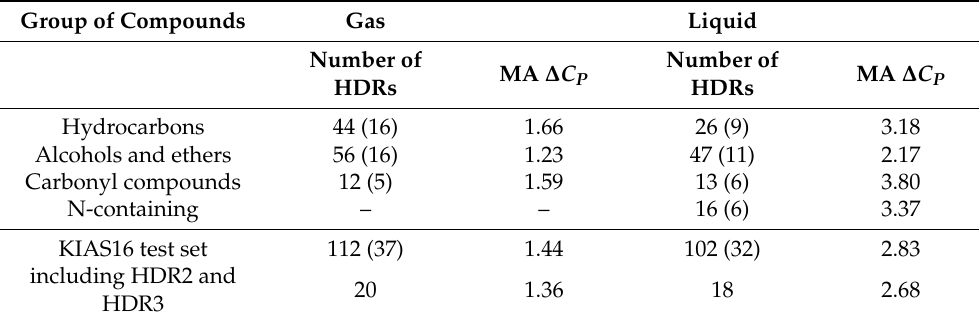
Table 4. Mean absolute value of HDR heat capacities (MA ∆ C P , J/mol · K) determined on the base of experimental data, 298 K 1,2,3